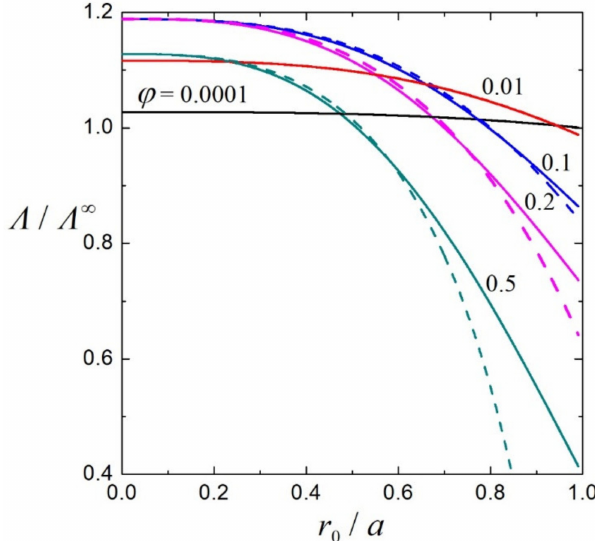
Figure 9. Normalized effective electric conductivity Λ / Λ ∞ versus r 0 / a for a suspension of soft spheres with Q = 4 and ϕ as a parameter. The solid and dashed curves denote results obtained from conditions (13) and (14), respectively, at the cell